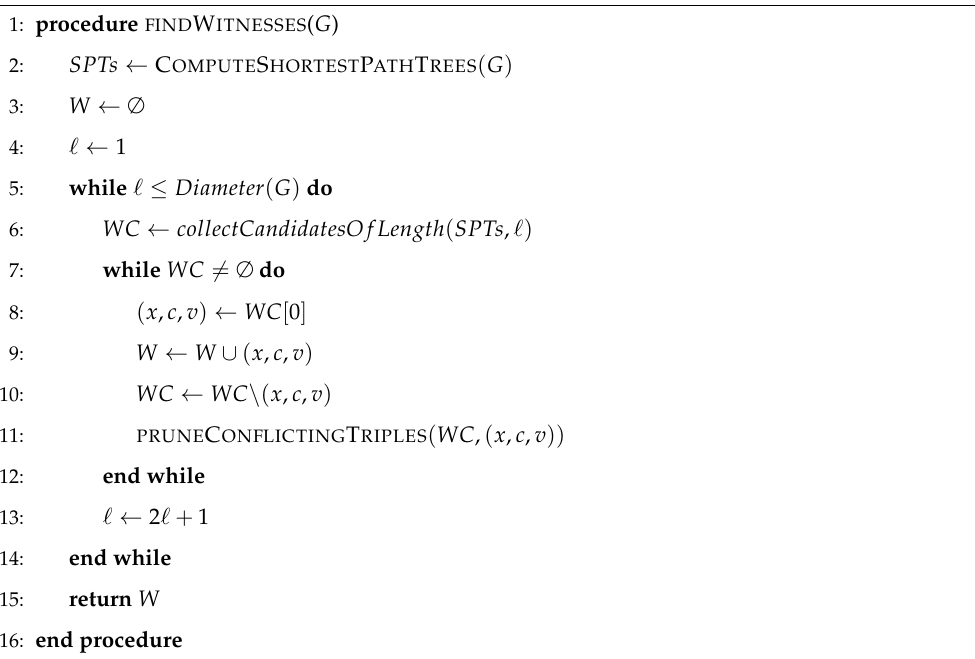
Algorithm 1 The algorithm to find a set of non-conflicting witness